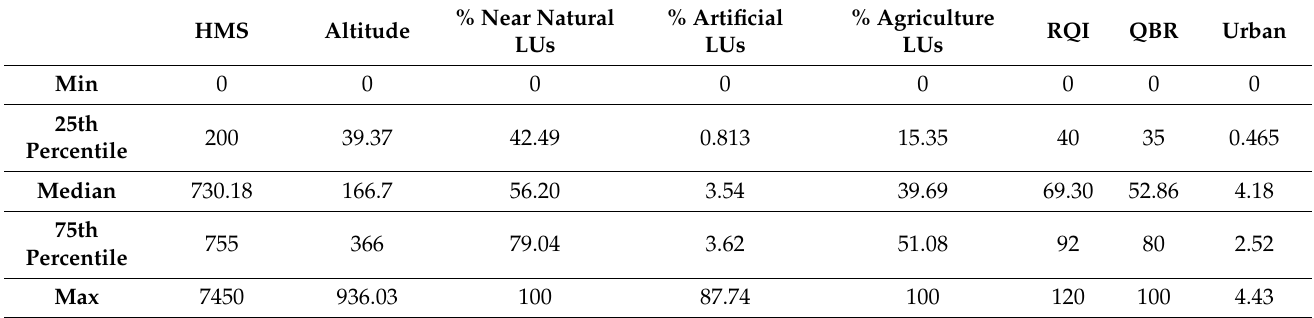
Table 5. Min, 25th percentile, median, 75th percentile and max of Land Uses (LUs), altitude, QBR, RQI, and HMS. HMS